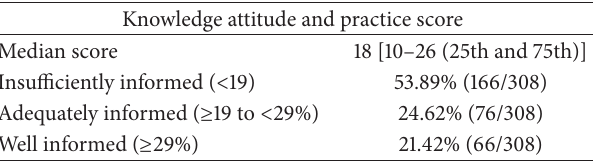
Table 2: Knowledge score regarding cervical cancer.